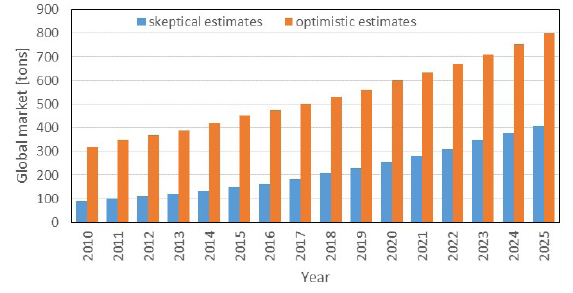
Figure 3: The global market for silver nanoparticles Table 3: Prices of silver nanoparticles [3].